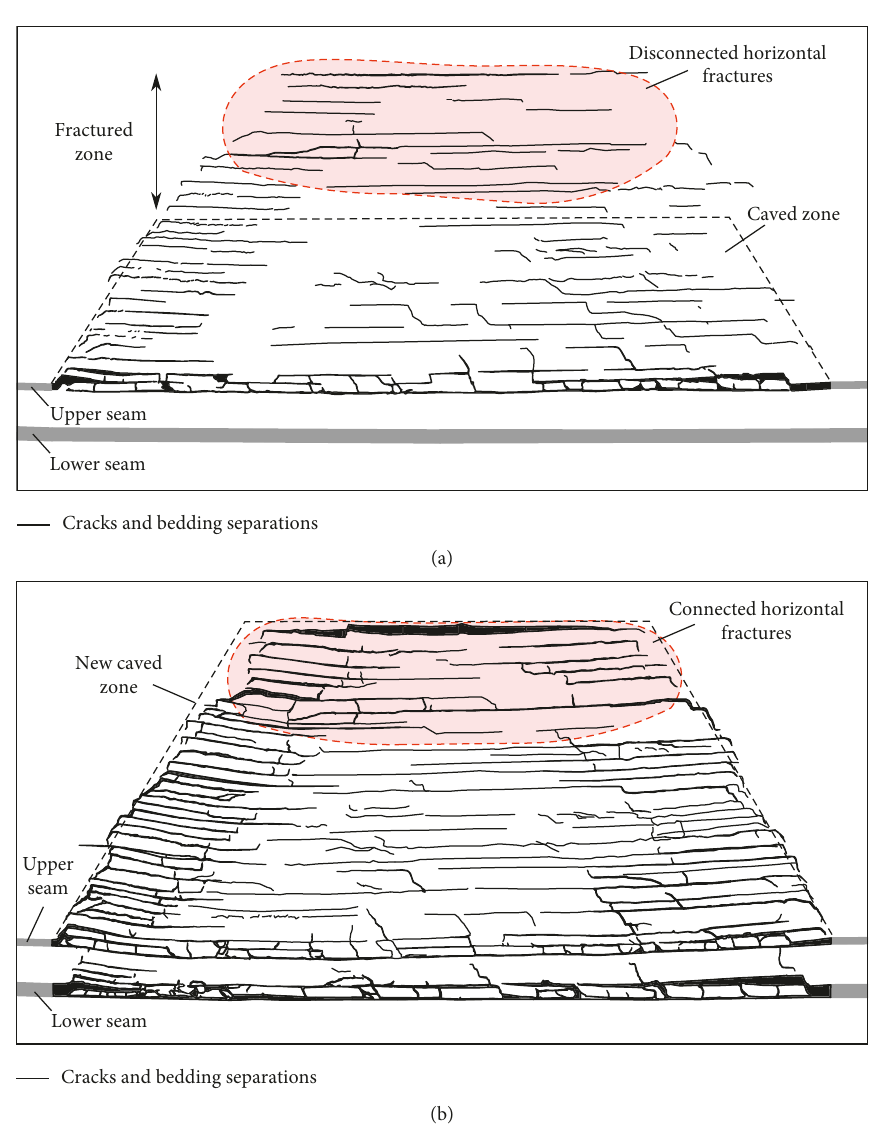
Figure 13: Changes in density and connectivity of horizontal fractures close to the top of the caved area after (a) single-seam and (b) multiseam extractions in Case